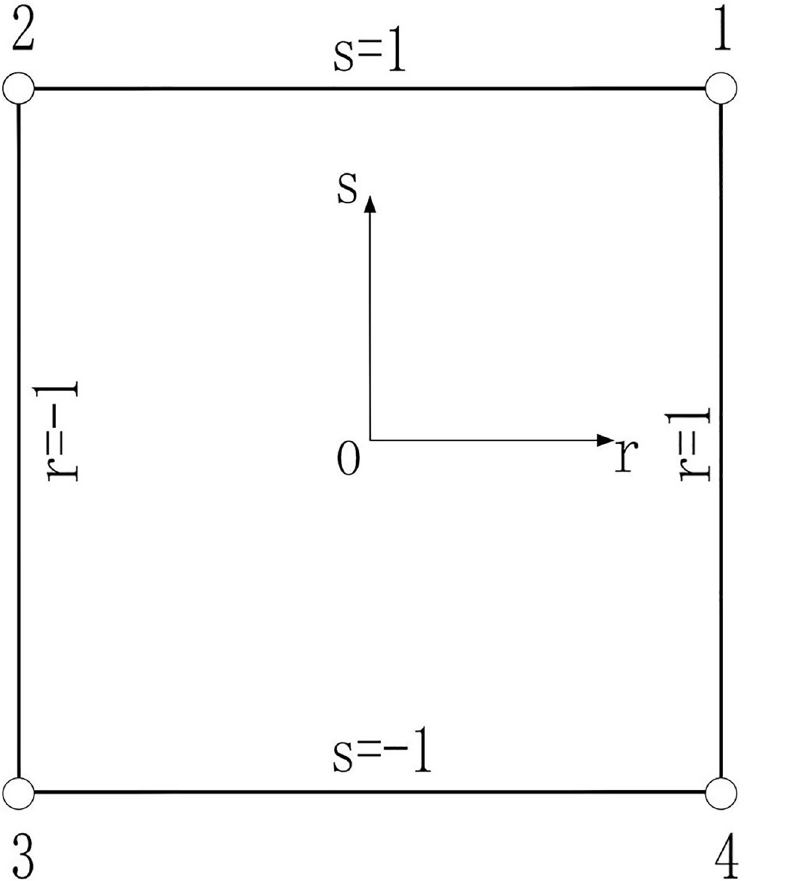
Fig 3. A 4-node rectangular element shape